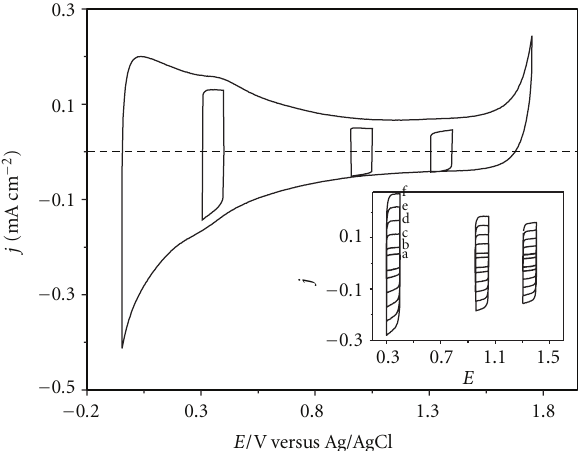
Figure 2: CVs of a representative Ti / SnO 2 -Sb-Ni electrode between − 0.05 and 1.75 V in three 100 mV ranges in 0.1M H Scan rate: 50mVs − 1 . The inset shows CVs of the electrode in the three 100 mV ranges at di ff erent scan rates: 5, 10, 20, 30, 40, and 50mVs − 1 form a to f, respectively. The CVs at higher scan rates are not